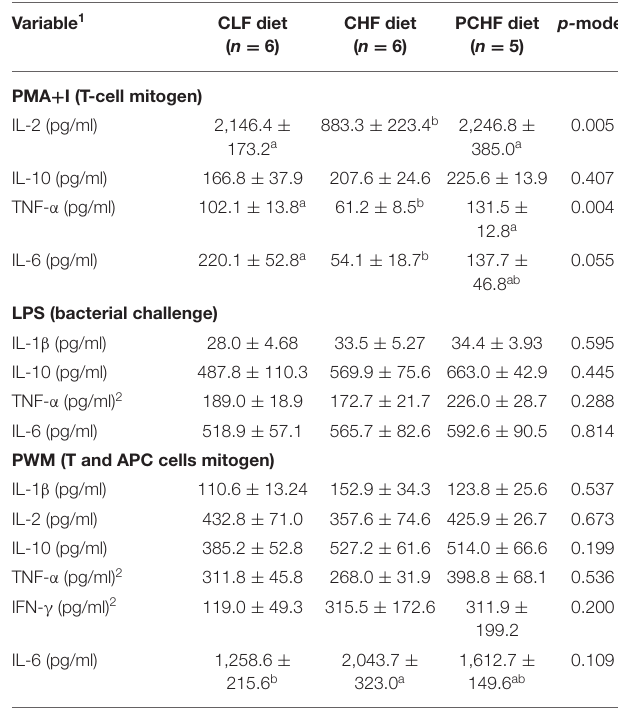
TABLE 4 | Ex vivo cytokine production by mitogen-stimulated splenocytes of male Wistar rats fed the three experimental